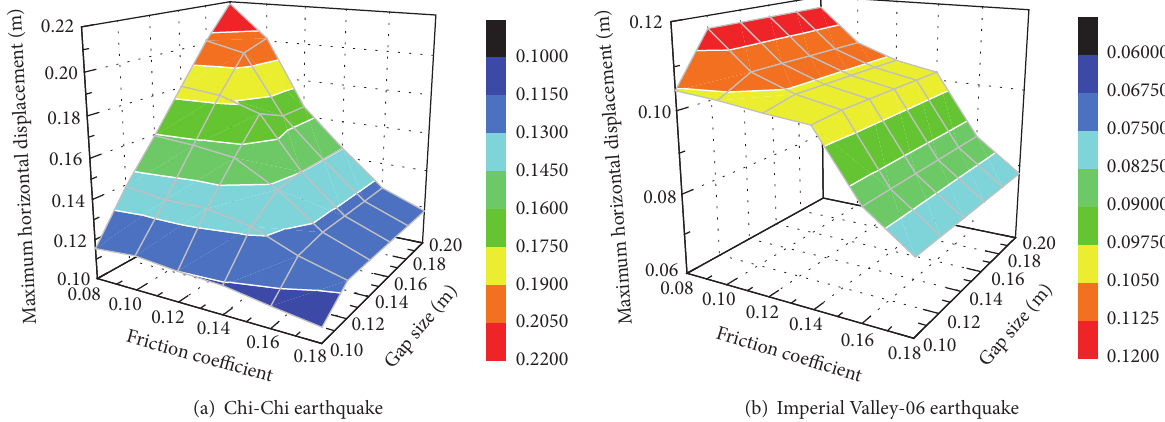
Figure 10: Correlation effects of the friction coefficient and initial gap on the maximum horizontal displacement of the structure.